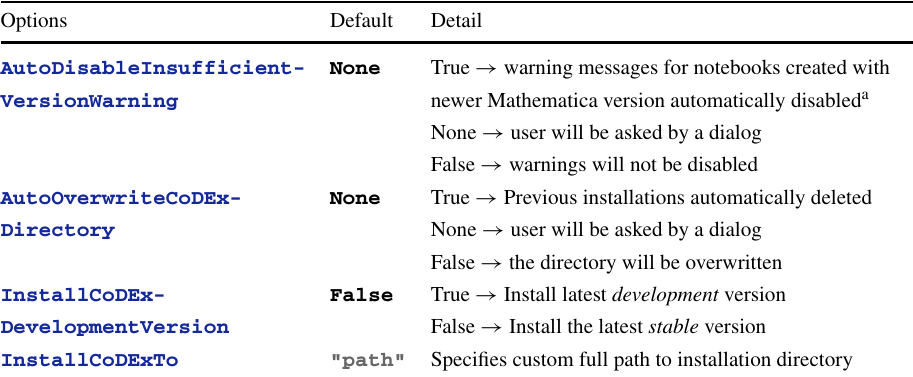
Options Default Detail ‘InstallCoDEx’ can be customized using its options AutoDisableInsufficient- None True → warning messages for notebooks created